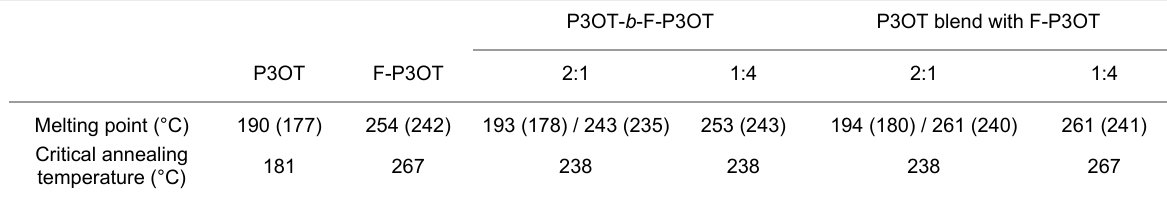
Table 1: Melting point of dropcast films taken as the maximum (onset in parentheses), and critical annealing temperature of spin cast films at which vibronic structure is mostly lost from the UV–visible